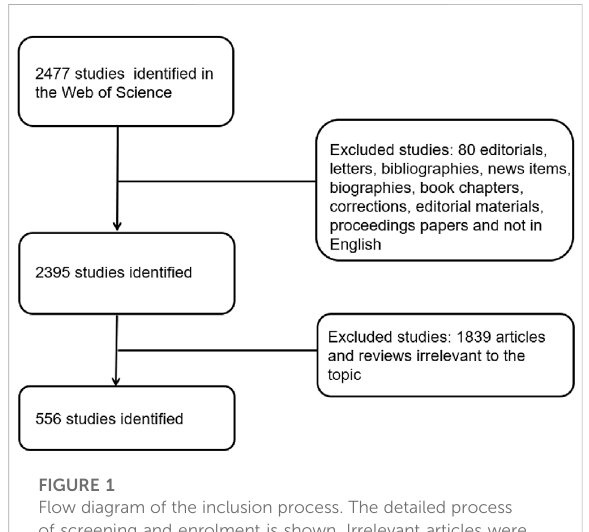
FIGURE 1 Flow diagram of the inclusion process. The detailed process of screening and enrolment is shown. Irrelevant articles were manually screened by two authors through their abstracts and full texts, and articles irrelevant to the topic were